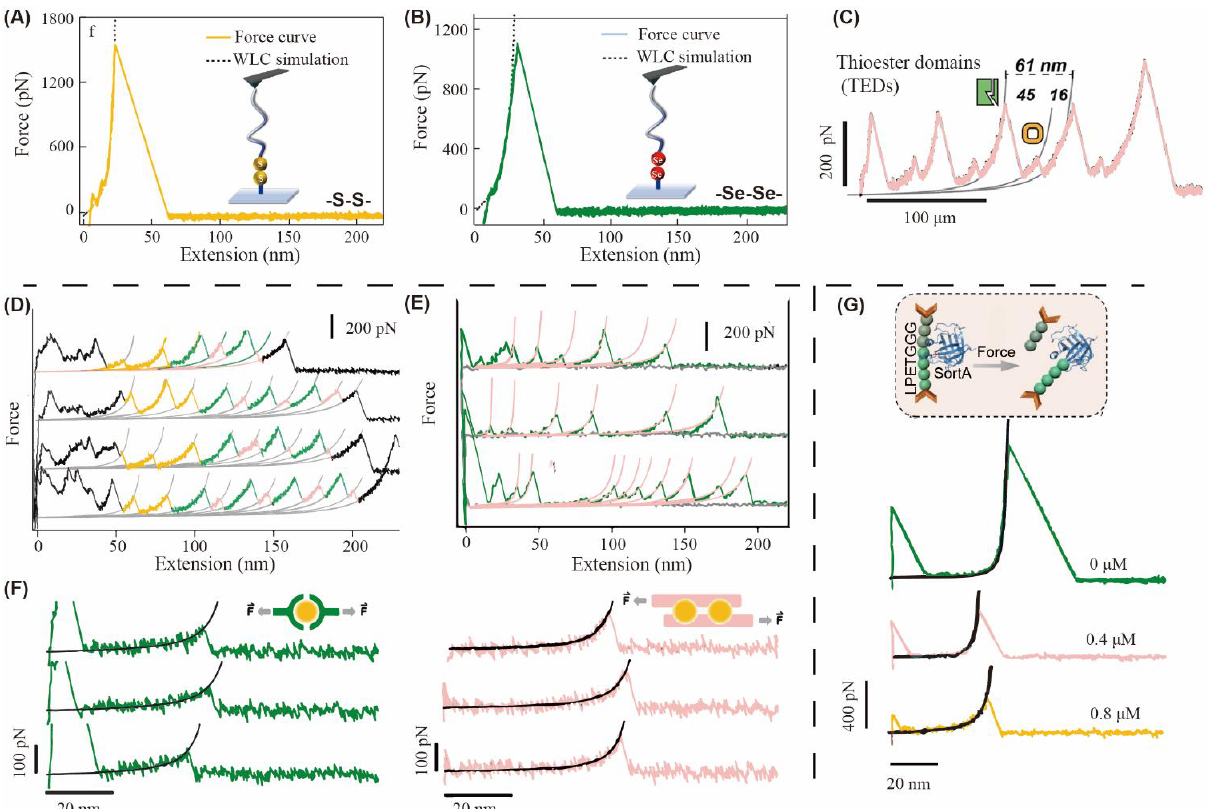
Figure 3. Mechanical measurements of different dynamic covalent bonds using atomic force micro- scope-based single molecule force spectroscopy (AFM-SMFS). Typical force–extension curves of the rupture of ( A ) disulfide bond and ( B ) diselenide bond [32]. Copyright © Editorial Office of Acta Polymerica Sinica; ( C ) schematic diagram of structure and force–extension recordings of the Poly-CnaBD595aTED (D595A ( ∆ iso) construct [38]. Copyright © 2017 by The American Society for Biochemistry and Molecular Biology, Inc.; ( D ) the typical force extension curve from the mechanical unfolding of Fe 2 S 4 [39]. Copyright © 2017, American Chemical Society ( E ) Study of single-molecule mechanics of catechol-Fe 3+ complexes by atomic force microscopy [78]. Copyright © 2017, American Chemical Society; ( F ) typical force – extension curves of the rupture of PH 3 -Zn 2+ (green line), and PH 6 -Zn 2+ (pink line) complexes [40]; ( G ) schematic for the single-molecule force spectroscopy of SrtA-induced cleavage of the LPETGGG peptide under force (top) and typical force-retract curves for the rupture of the LPETGGG peptide in different concentrations of enzyme(bottom) [41]. Copyright © 2022 Wiley-VCH GmbH.